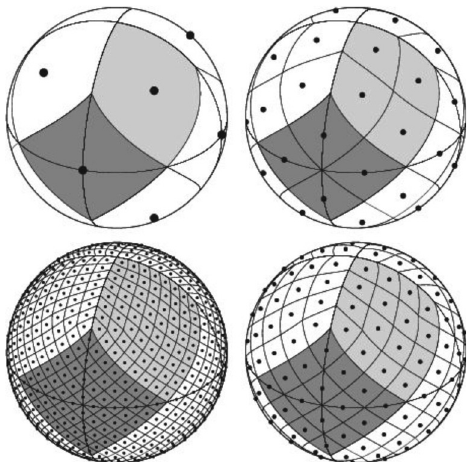
Fig. 5. Pixilation of the HEALPIX Sphere